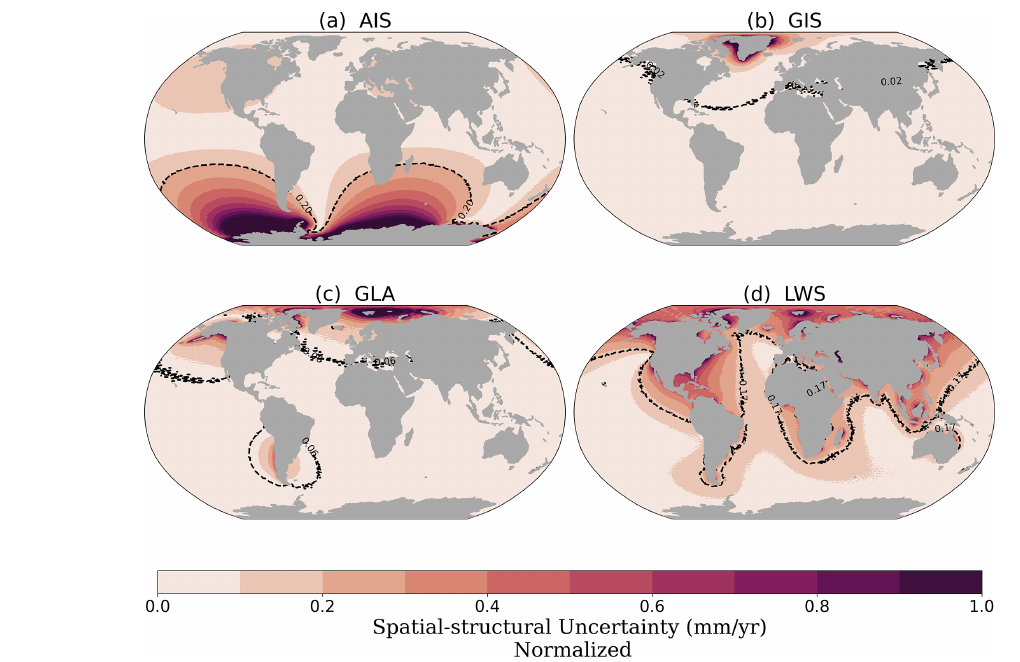
Figure 5. Normalized GRD-induced sea-level change fields of the spatial–structural uncertainty (0–1mmyr − 1 ), representing the uncertainty arising from the different locations of mass changes for Antarctica (a) , Greenland (b) , glaciers (c) and land water storage (d) . The black dashed contour line and number indicate the spatial average of the regional